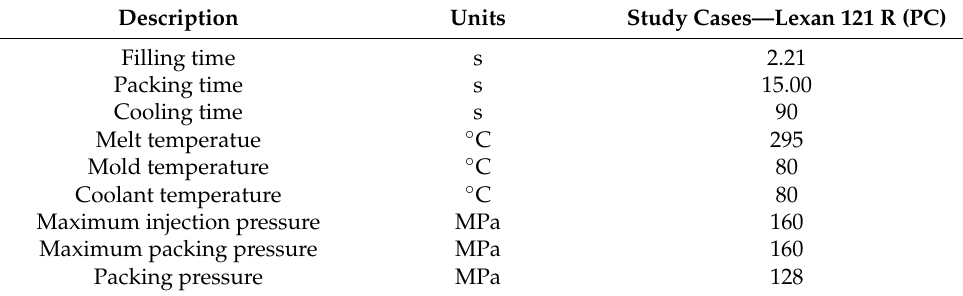
Table 6. Magnitude of the physical properties of the defined